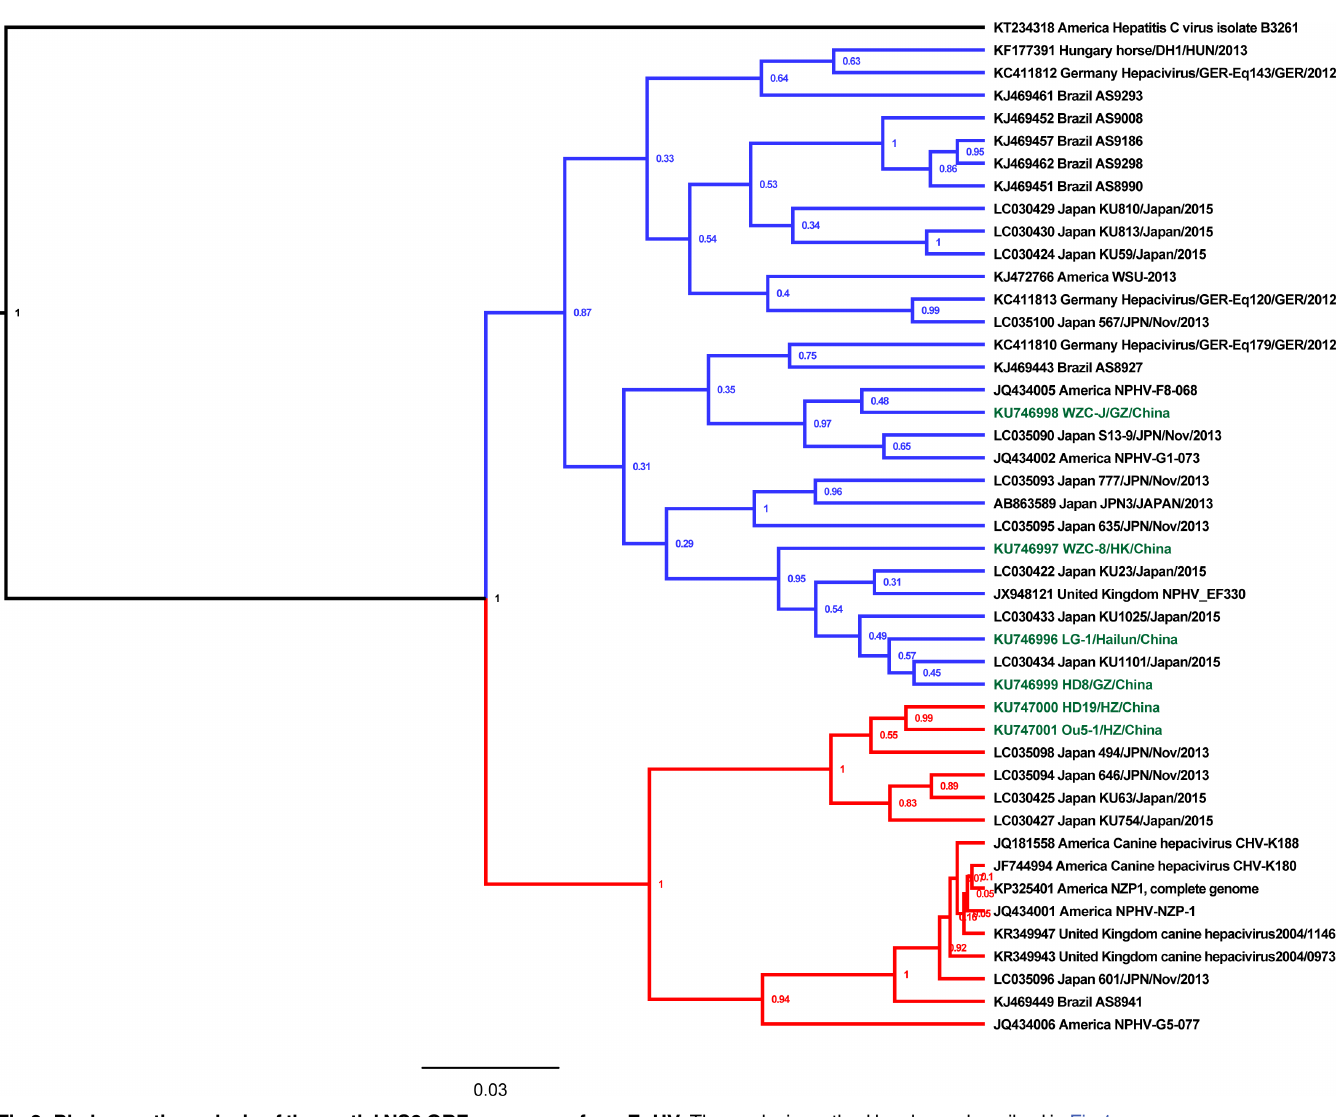
Fig 2. Phylogenetic analysis of the partial NS3 ORF sequences from EqHV. The analysis method has been described in Fig